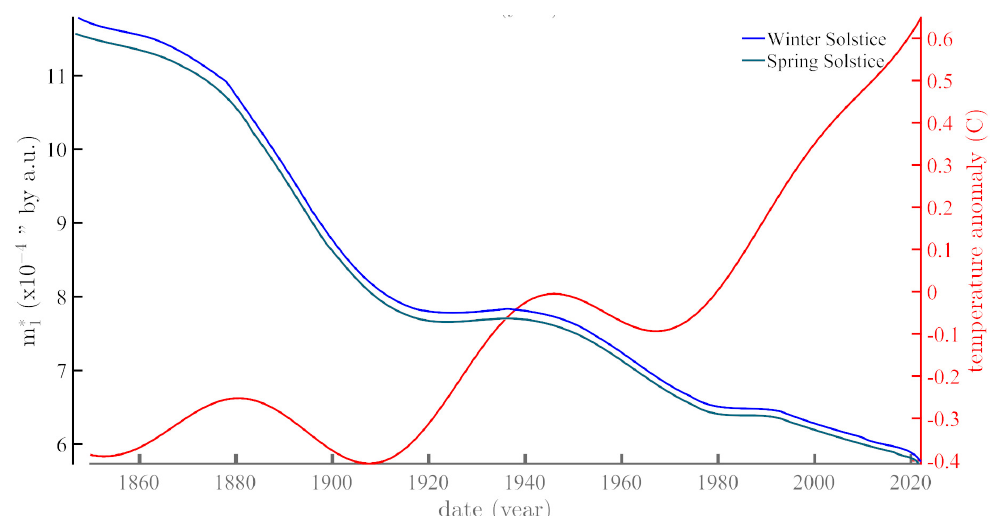
Figure 9. Superposition of the time evolution of the winter (blue curve) and summer (green curve) solstices for component m ∗ from Figure 7a and the first iSSA component (trend) of the median of the 1 five HadCrut Center temperature series from Figure 8a (red